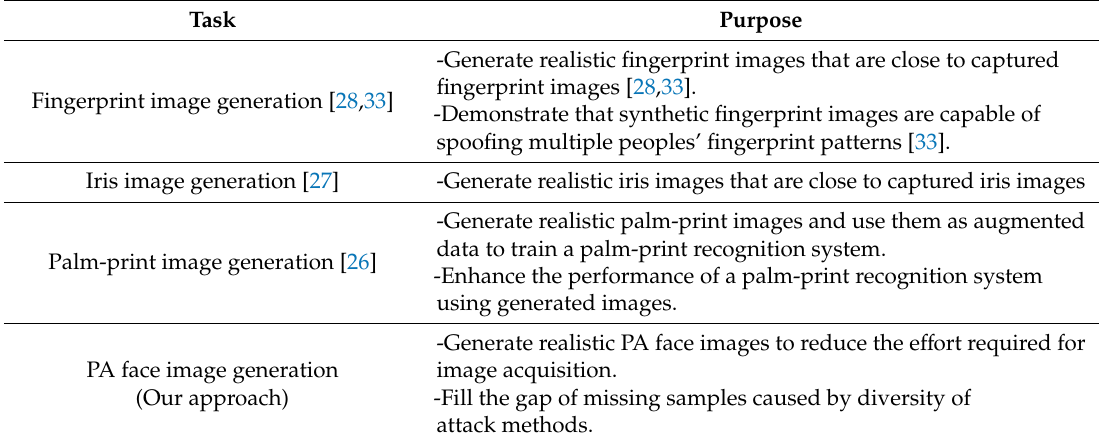
Table 1. Summary of GAN-based image generation methods for biometrics systems.